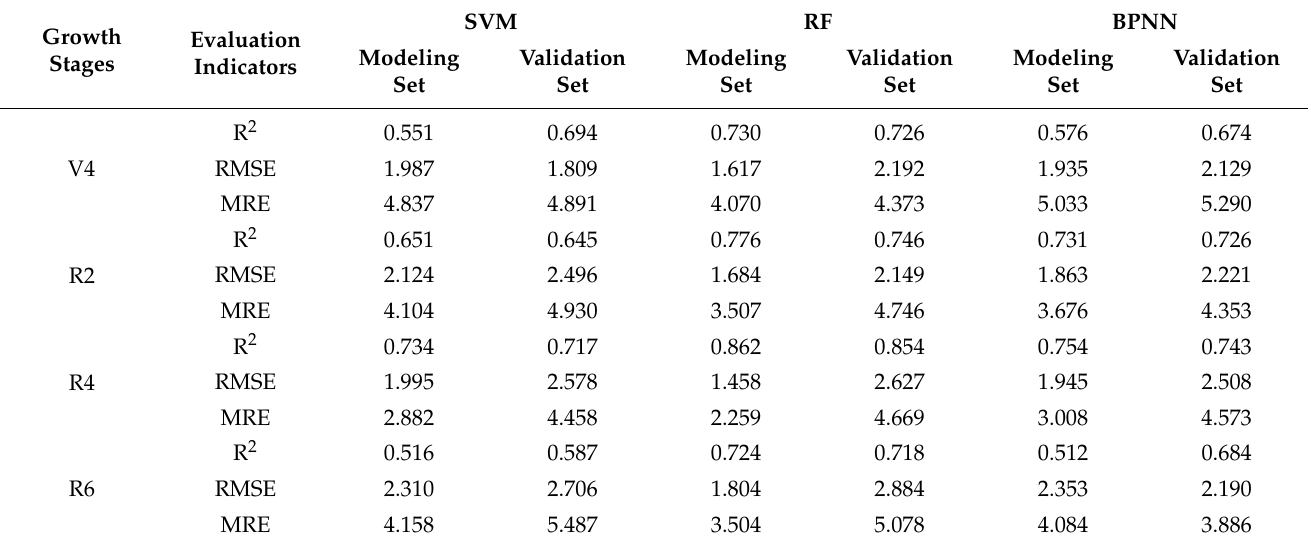
Table 4. Comparison of model prediction accuracy evaluation under different growth